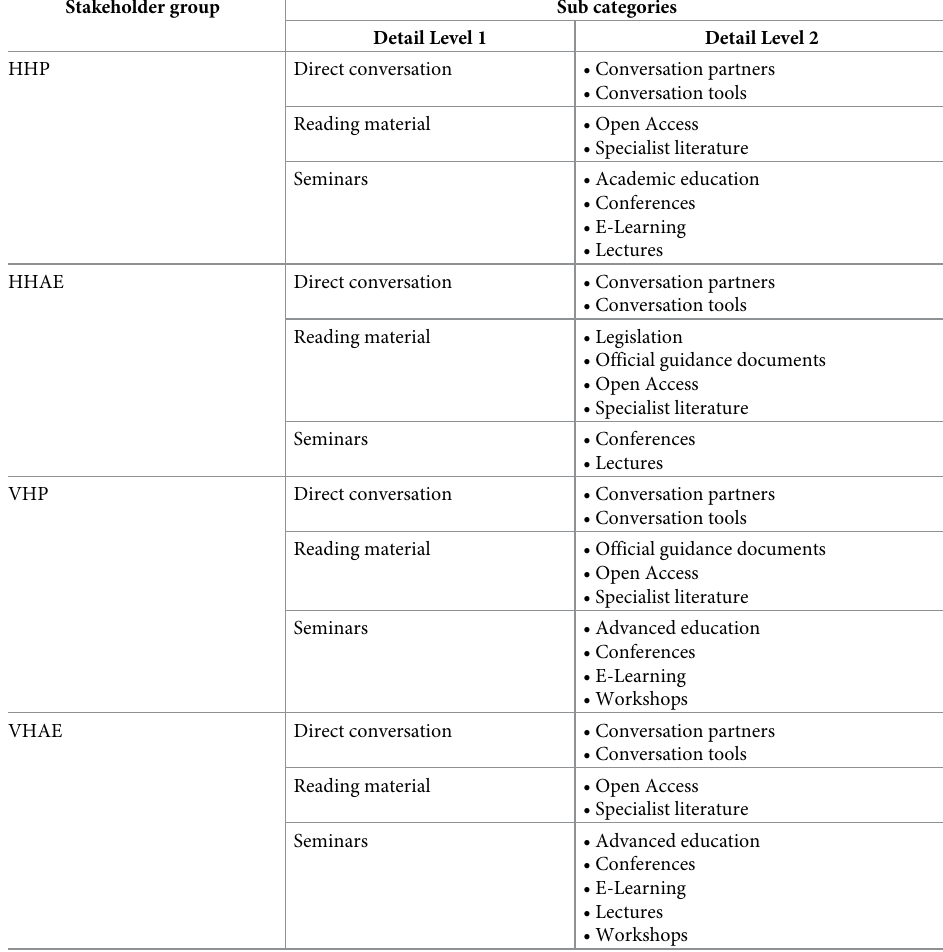
Table 5. Most suitable information sources to close knowledge gaps about Q fever (focus group